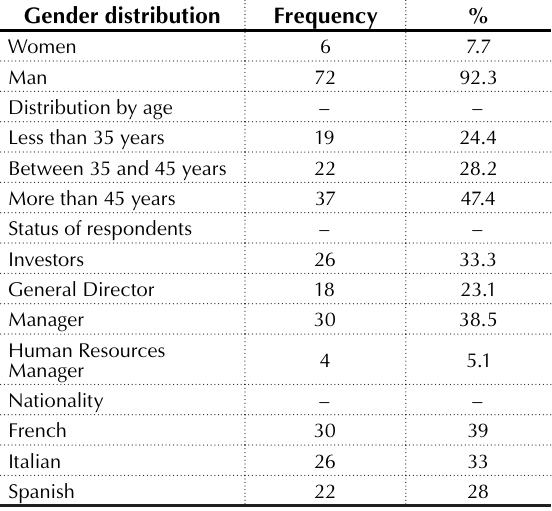
Source: Authors’ calculation.